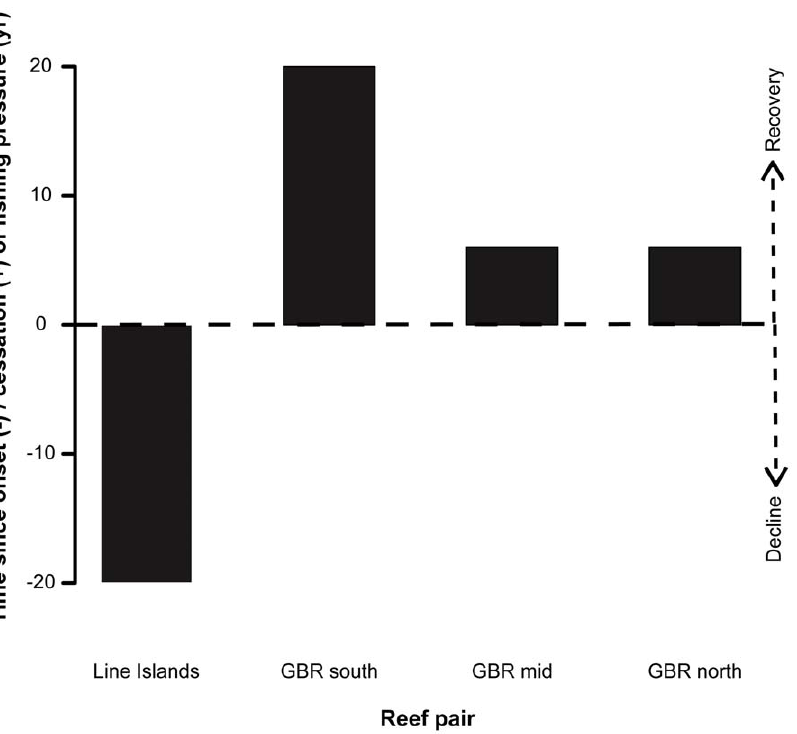
Figure 1. History of fishing pressure on reef fishes for reef pairs used in this study. X-axis indicates reef pair. Y-axis indicates the amount of time elapsed since either onset (Line Islands) or cessation (GBR) of fishing in each of the reef pairs, in years. Negative values therefore represent the length of time that the Eastern Indo-Pacific (Line Islands) fished site has been exploited (i.e., indicated as ‘‘decline’’ by dashed arrow on right-hand y- axis), whereas positive values represent time since cessation of fishing at protected Central Indo-Pacific (GBR) sites (i.e., as indicated by the ‘‘recovery’’ side of dashed arrow). ‘‘Decline’’ and ‘‘recovery’’ refer to the presumed trajectory of reefs’ exploited fish populations due to fishing pressure, not to structural changes in reefs.